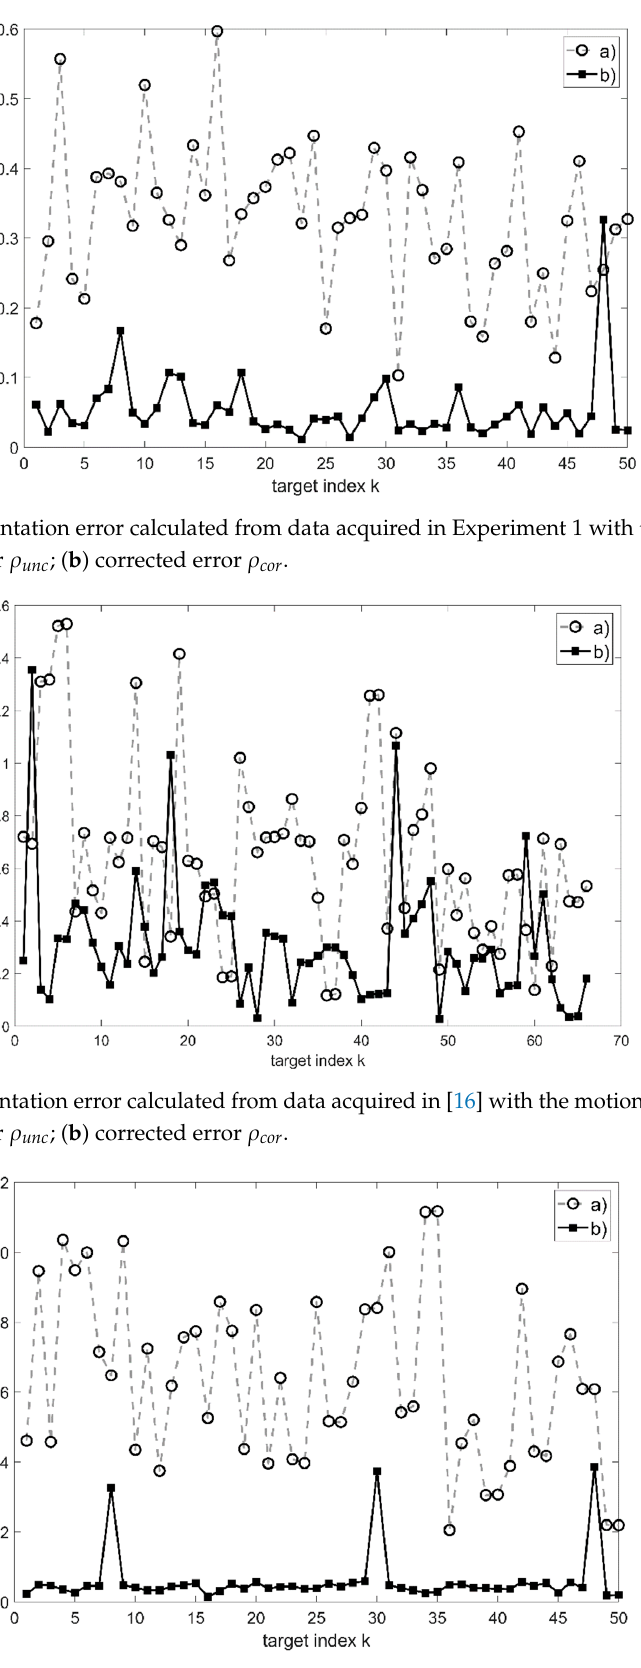
Figure 10. Target position error calculated from data acquired in Experiment 1 with the laser tracker: ( a ) uncorrected error δ unc ; ( b ) corrected error δ cor